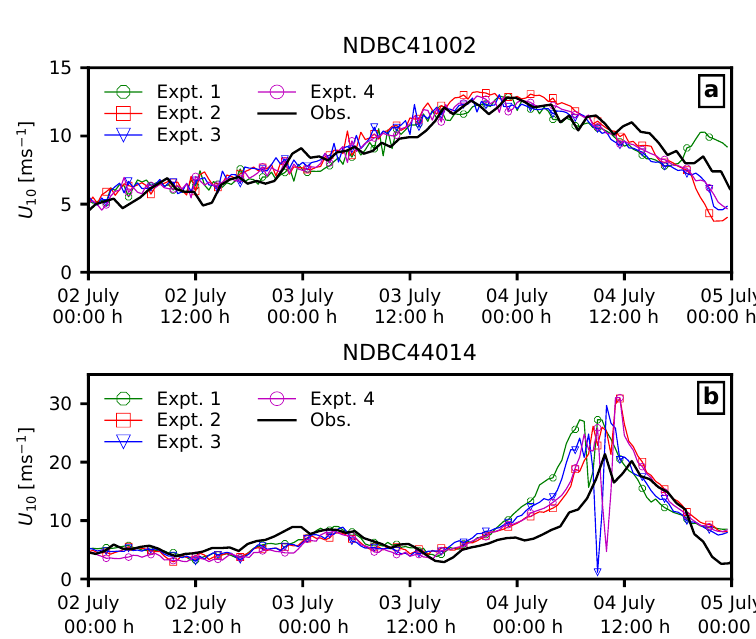
Figure 7. Comparison of coupled model results with NDBC buoys (a) 41002 and (b) 44014 for mean wind speed U 10 (ms − 1 ) at 10m elevation.